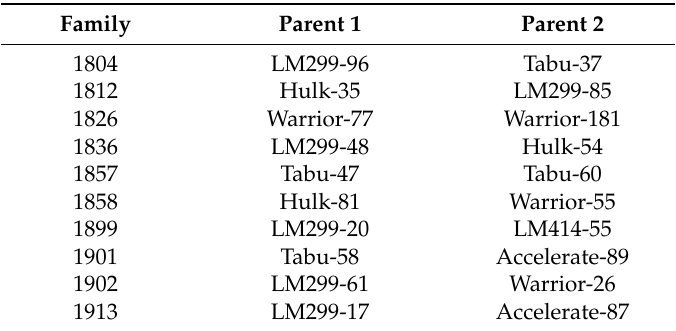
Table 2. Selected 10 bi-parental F 1